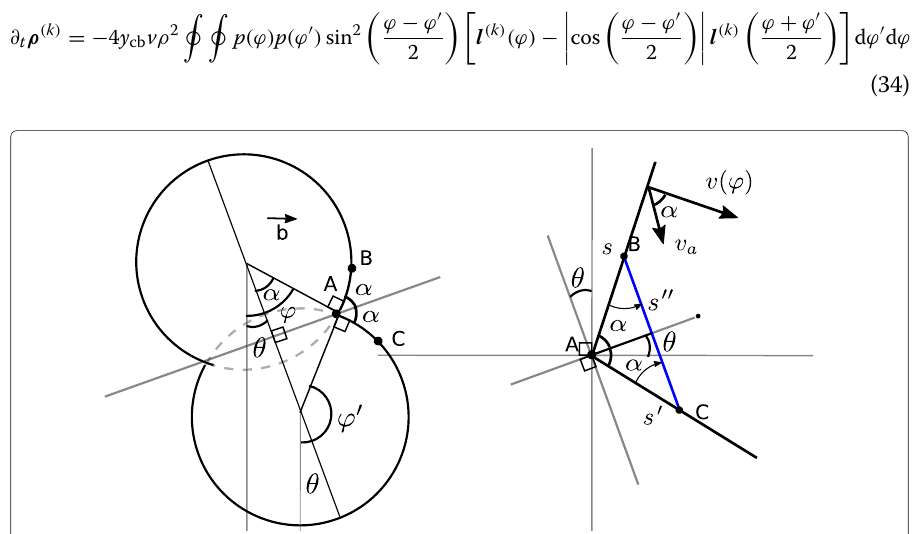
Fig. 4 Left: Two dislocation loops are merging by climb annihilation initiated at segments with angles θ and π + θ . Right: Interaction between segments s (ϕ) and s (ϕ (cid:10) = π + 2 θ − ϕ) generates a news segment s (ϕ (cid:10)(cid:10) ) with orientation perpendicular to